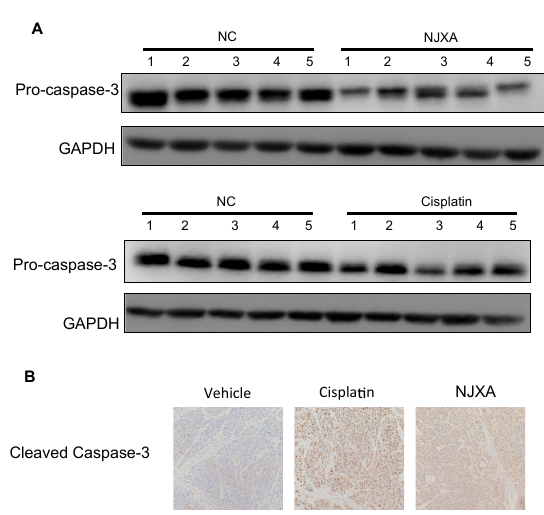
Figure 5. NJXA induced cleavage of pro-caspase-3 in xenografted tumors. HeLa cells (1 × 10 6 cells per mouse) were injected subcutaneously into the dorsal flank of nude mice. When the tumors reached approximately 75 mm 3 , the mice received a daily intraperitoneal injection of either the vehicle control (1% Tween-80 in normal saline) or NJXA (20 mg/kg) or an injection of cisplatin (2 mg/kg) every 2 days. After treatment for 16 days, the mice were sacrificed. ( A ) Western blotting analysis of the expression levels of pro-caspase-3 and GAPDH protein in mouse tumor sections; ( B ) Representative images of tumor sections immunohistochemically stained to examine the cleaved caspase-3 level.